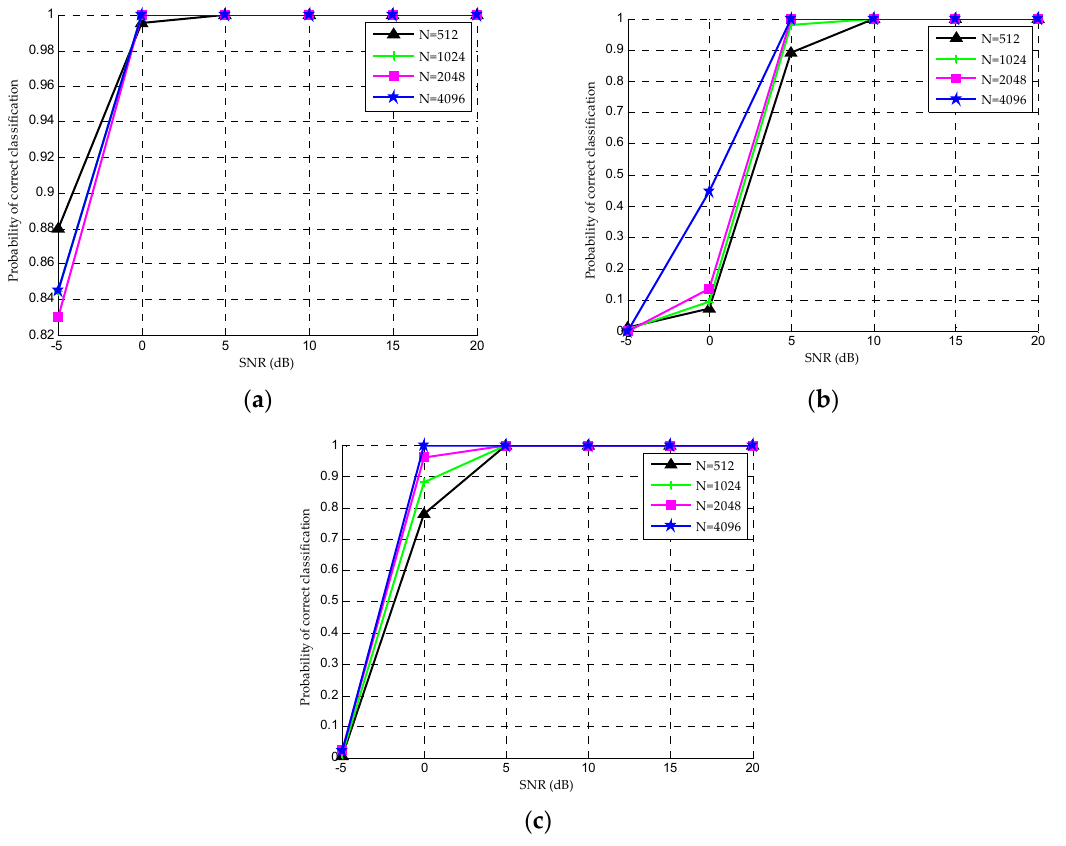
Figure 5. Correct classification rate with different symbol length for ( a ) OOK, ( b ) QPSK and ( c ) 16QAM under different SNRs.